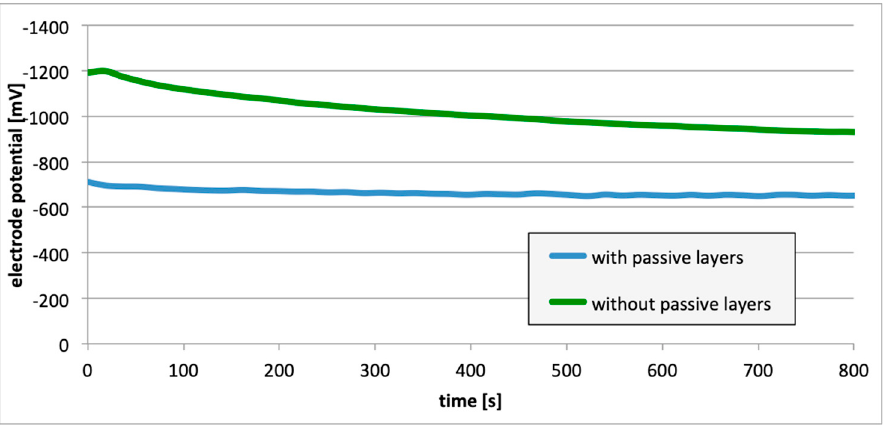
Figure 15. Electrode potential change following removal of passive layers (EN AW-6060).